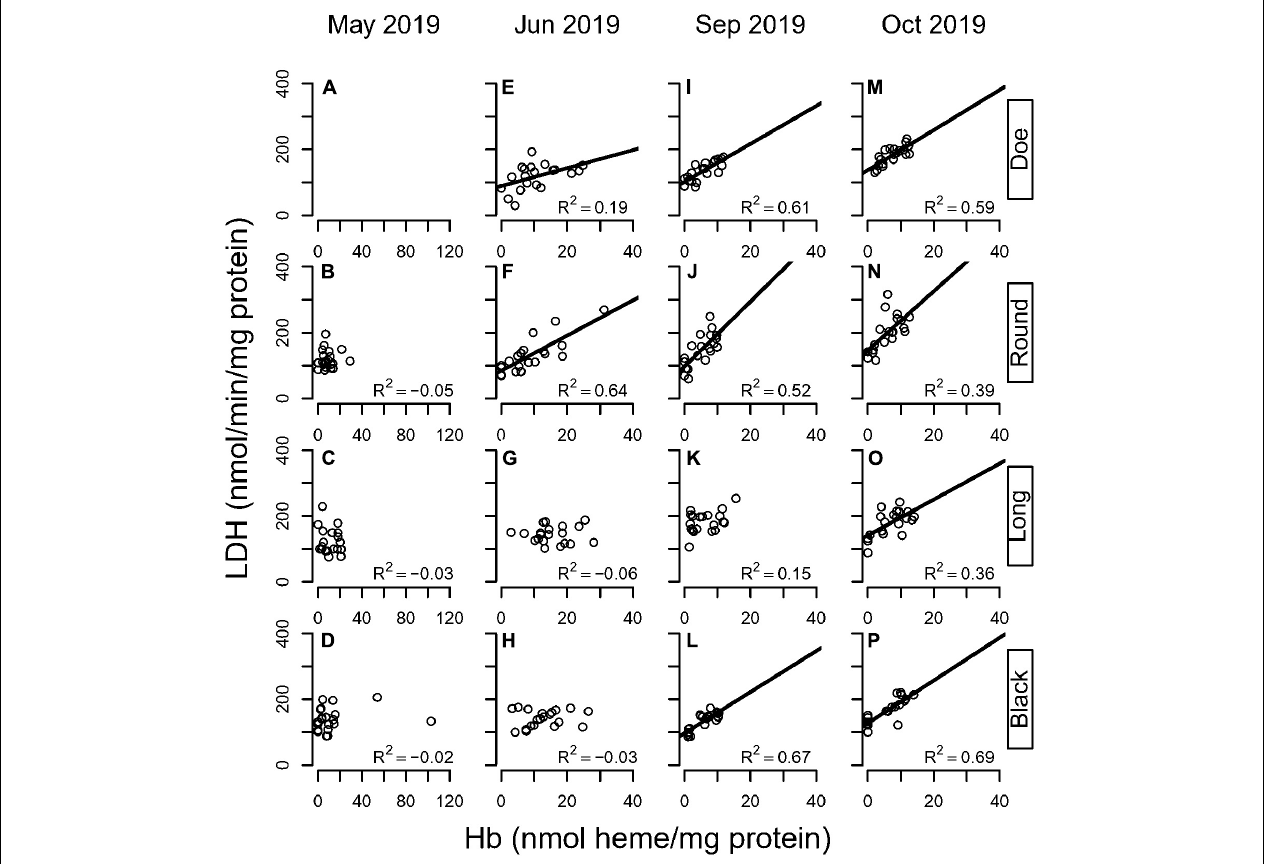
FIGURE 6 | Correlation between LDH and hemoglobin in four hypoxic lakes across months ( A–D : May; E–H : June; I–L : September; M–P : October) in D. pulicaria . Each circle is a sample of three animals. Lines denote statistically significant relationships ( p <